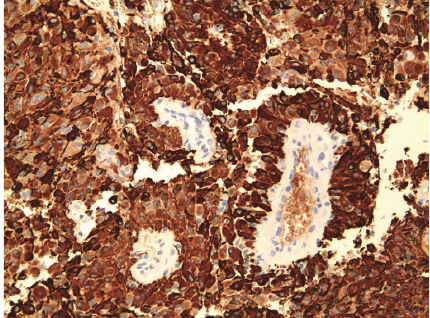
Figure 6: Glial fibrillary acidic protein (GFAP) stain shows positive staining demonstrating the glial origin of tumor cells (20x). Again, we can appreciate the tumor cells arranged in a perivascular pseudorosette with tumor cells directed toward the central blood vessel and the lack of